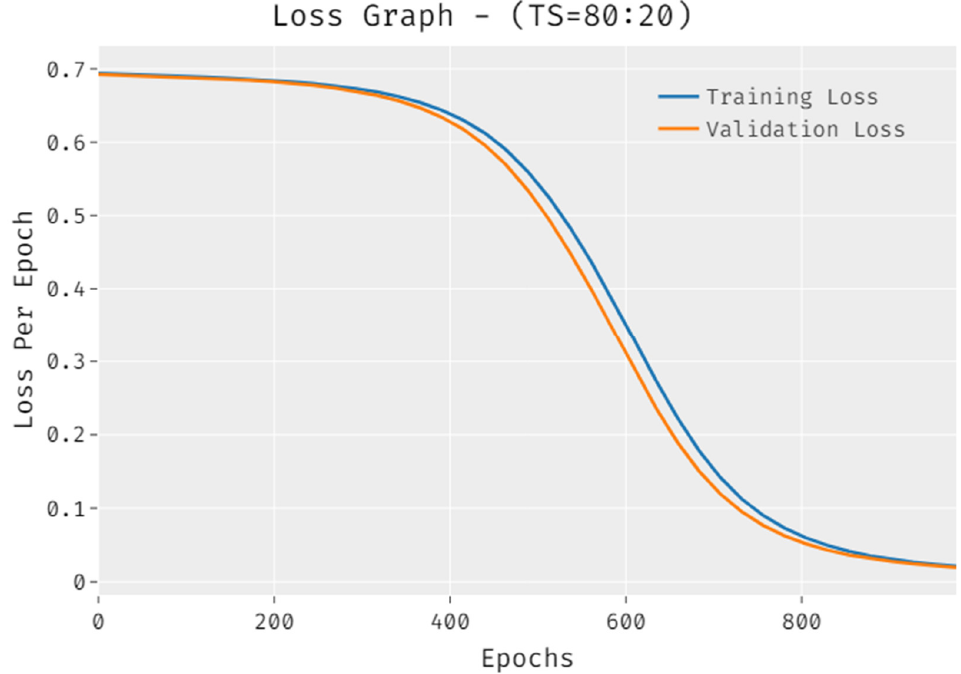
Figure 5. Loss of IDLDMS-PTC technique under training set (80:20).